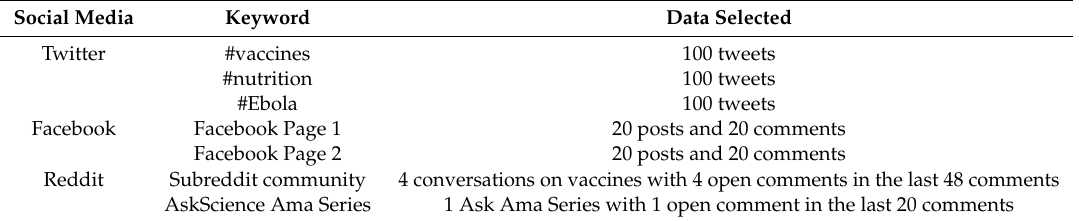
Table 2. Final sample selected for the social impact in social media (SISM) analysis.